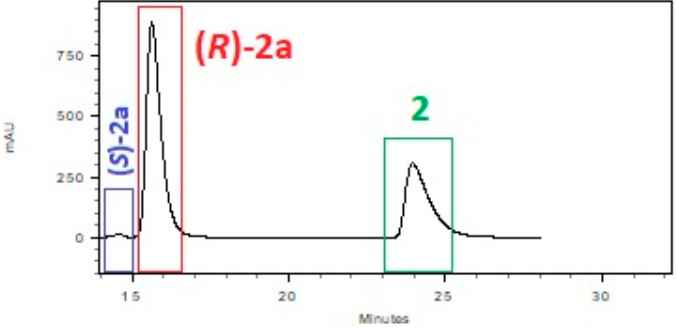
Figure 3. Reduction of 2 in phosphate buffer solution (pH = 7.0) with glucose.